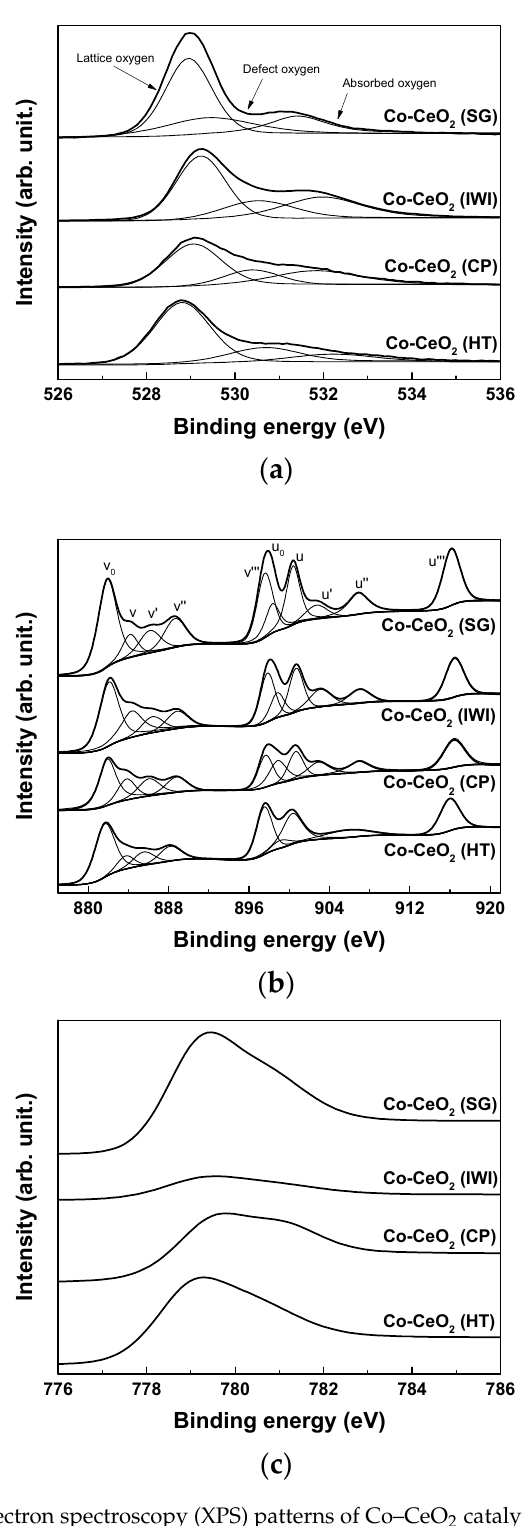
Figure 3. X-ray photoelectron spectroscopy (XPS) patterns of Co–CeO 2 catalysts prepared by different synthetic methods: ( a ) O 1s, ( b ) Ce 3d, ( c ) Co 2p.